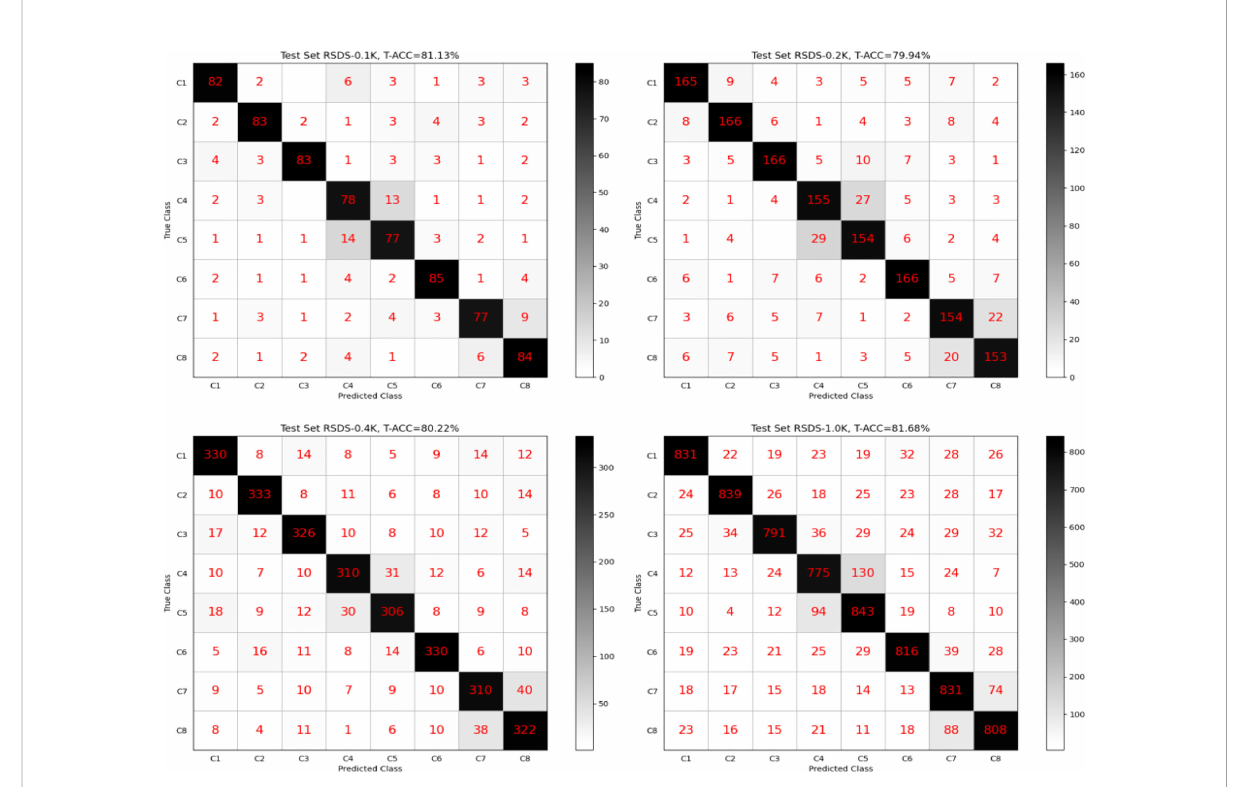
FIGURE 5 Confusion matrixes generated by TD-NAS on VGGNet-D